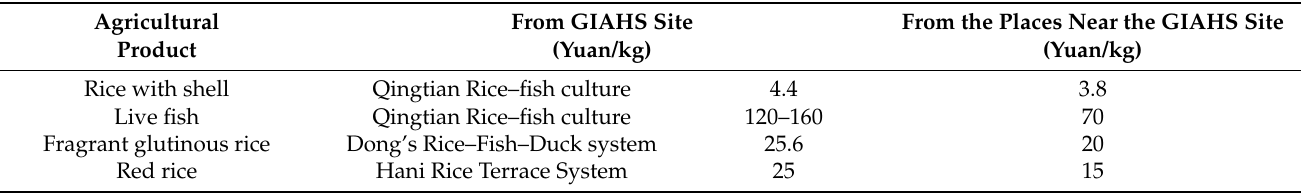
Table 1. Price of the rice with GIAHS brand in different GIAHS sites in